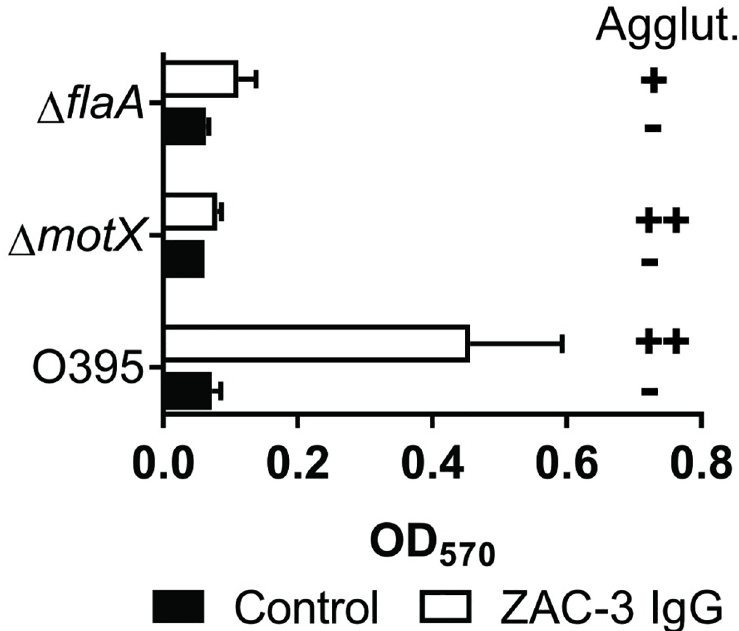
Fig 5. Non-motile V . cholerae O395 mutants do not produce ECM in response to ZAC-3. Relative CV levels produced by V . cholerae O395 Δ motX (non-motile) and Δ flaA (aflagellate) mutants, as compared to wild-type V . cholerae O395, in response to ZAC-3 IgG or an isotype control (9 μg/mL) after 2.5 h. For wild type V . cholerae O395 (but not the motility mutants), CV staining levels were significantly higher in the ZAC-3 treated group as compared to the control ( P < 0.05). The graph constitutes three biological replicates with three technical replicates each. Statistical significance was determined by two-way ANOVA, followed by a Tukey multiple comparison test. Macroagglutination (Agglut.) scale is as follows;—no agglutination; ++, agglutination within 2 h; +, agglutination within 3 h.